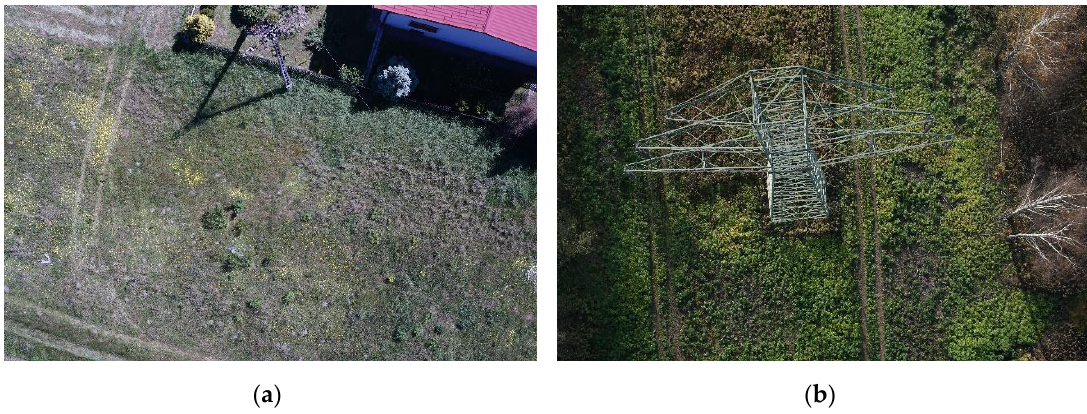
Figure 14. Example images of utility poles supporting power lines: ( a ) for Dataset I; ( b ) for Dataset II. Table 2. UAV on-board global navigation satellite system (GNSS) receiver parameters.